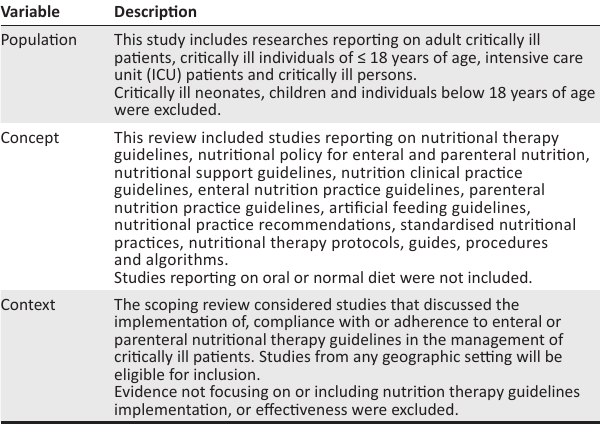
TABLE 1: Eligibility criteria for the review question. A PCC framework for determination of eligibility of review